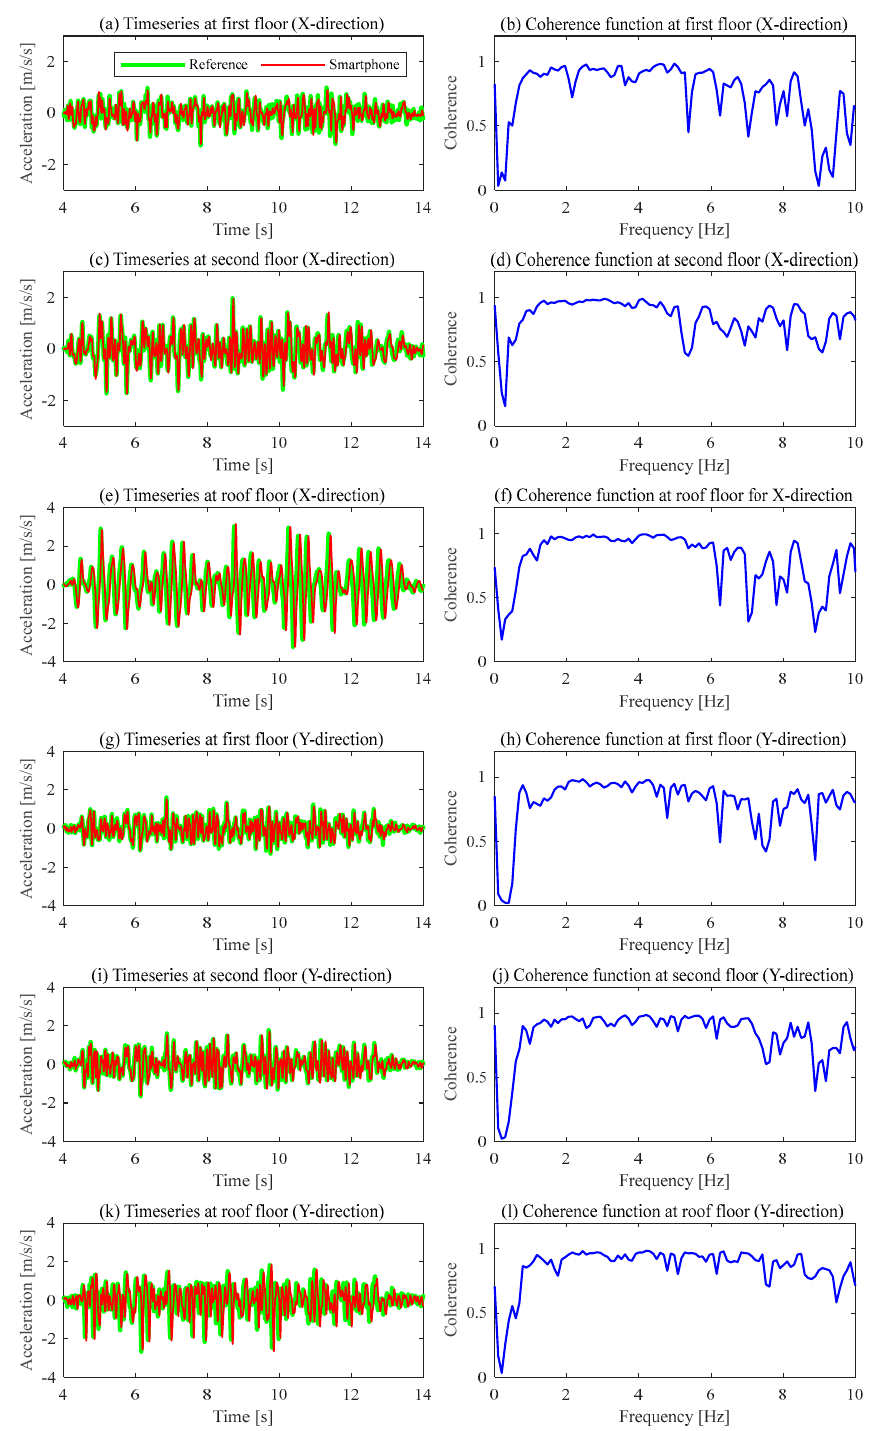
Figure 5. Comparison of time series between acceleration obtained from reference accelerometers and smartphones, and coherence for the X and Y directions in test